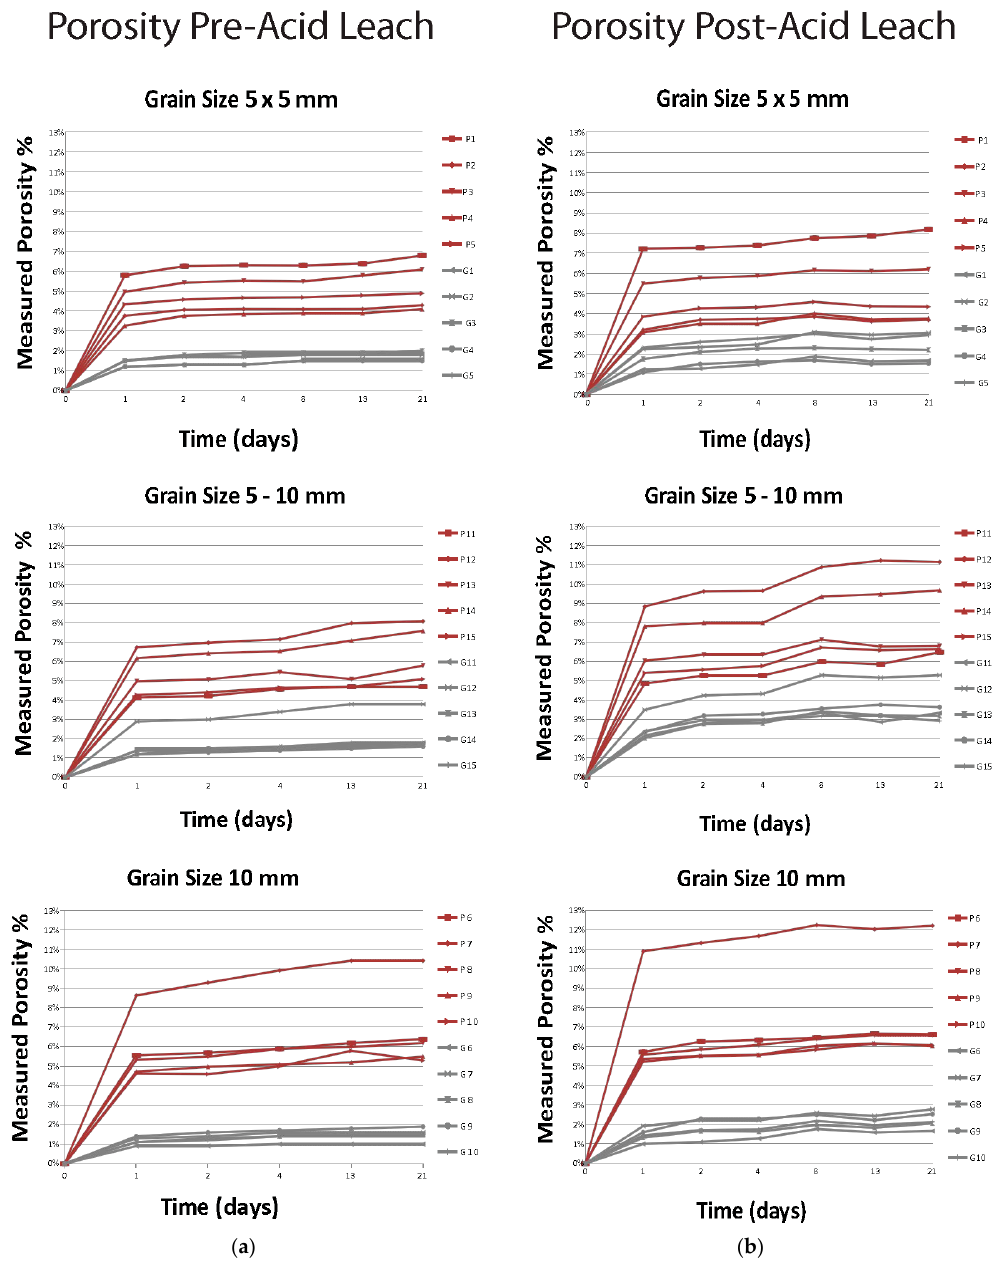
Figure 5. Estimated porosity measurements: ( a ) Pre-acid leach experiments; ( b ) Post-acid leach experiments. Red lines = pink samples; Gray lines = gray samples.